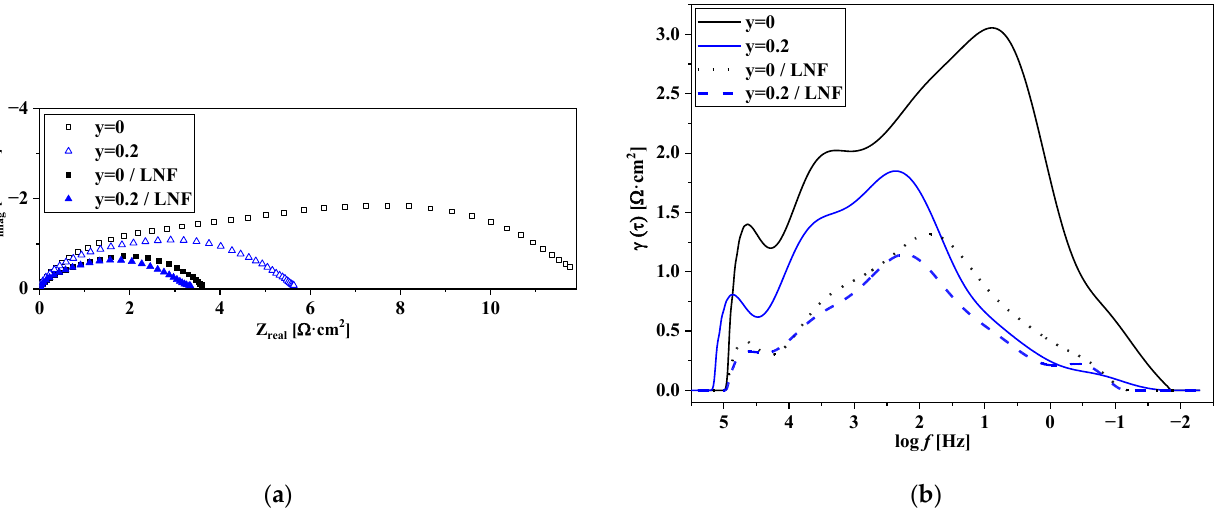
Figure 11. EIS spectra ( a ) and DFRTs ( b ) (at 700 ° C) for the symmetrical cells with the NCNCO00 and NCNCO02 functional layers sintered at 1000 ° C and the LNF + 3 wt.% CuO collector sintered at 900 ° C.